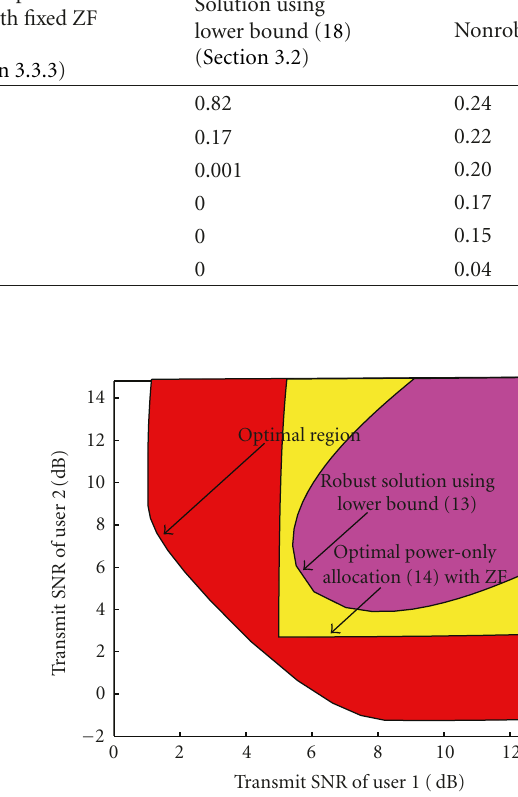
Figure 5: The feasibility regions of a 2-user (2,1) system for various robust algorithms for a particular channel realization.